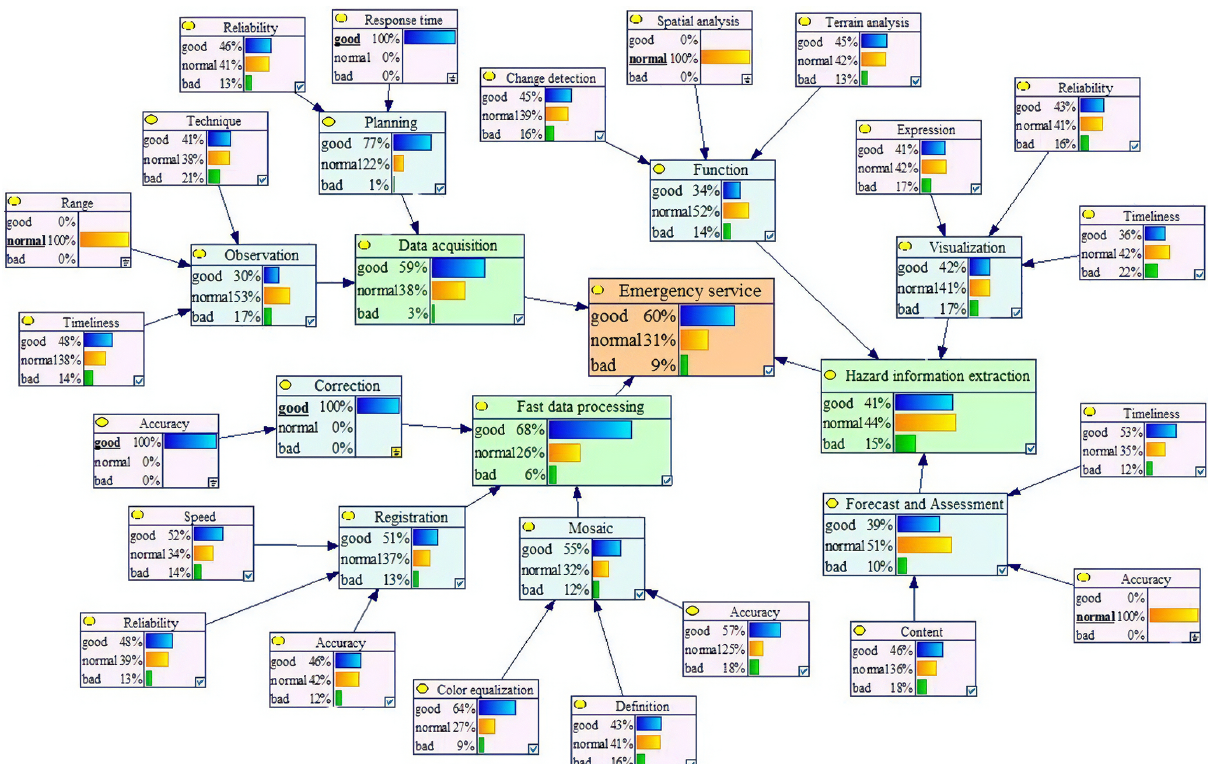
Figure 10. Capacity projection of collaborative emergency